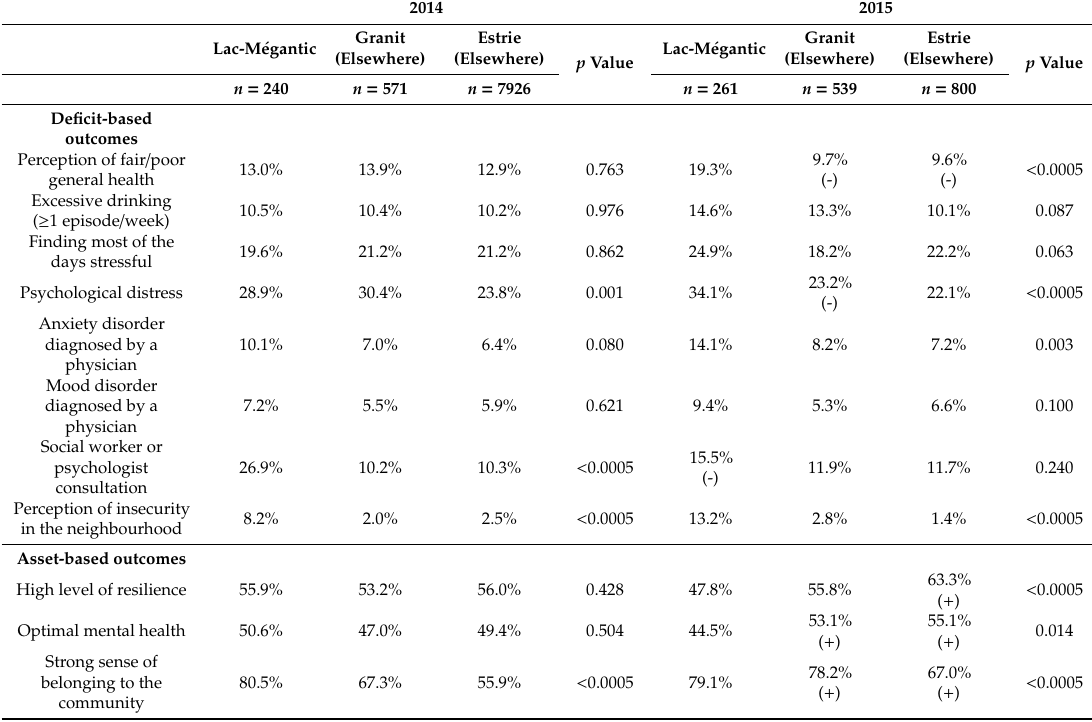
Table 1. Deficit- and asset-based outcomes among a community-based sample of adults according to residential location, two years and five years post-disaster (e.g., Lac-M é gantic train derailment, 6 July 2013), Estrie region, 2014 and